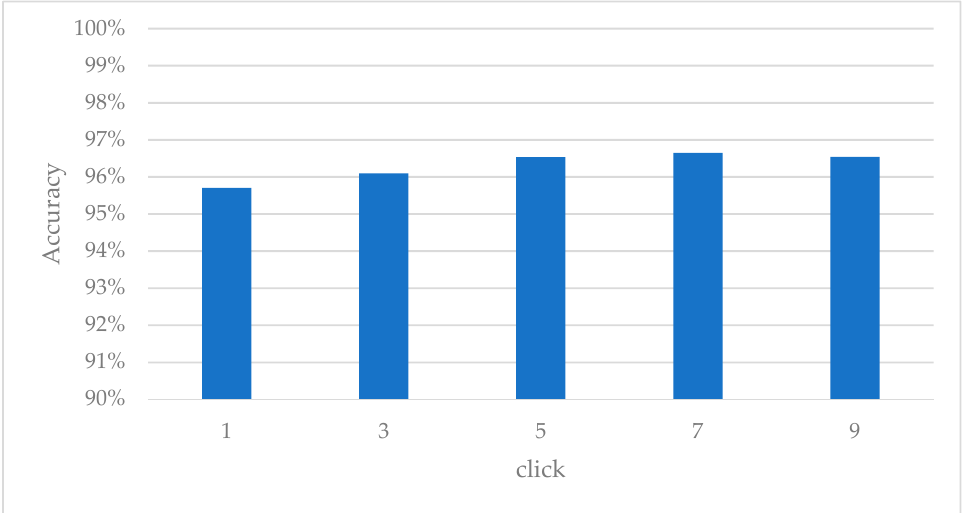
Figure 8. Accuracy comparison among 1–9 click sliding windows.